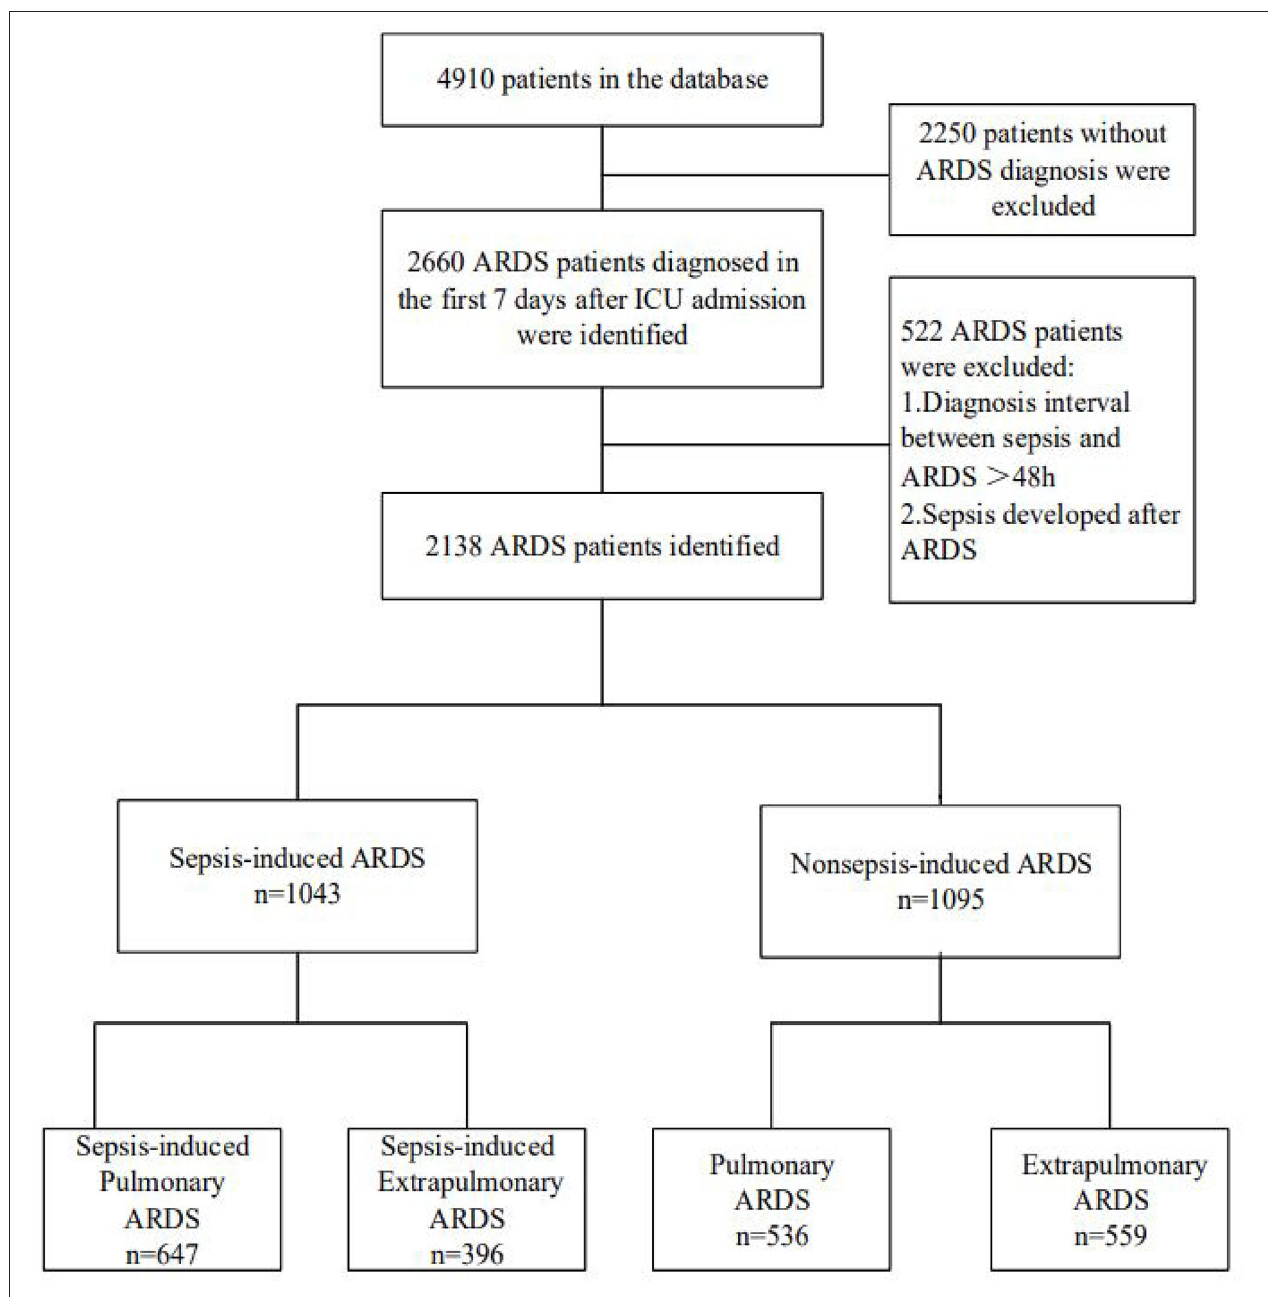
FIGURE 1 | Flowchart of this study.